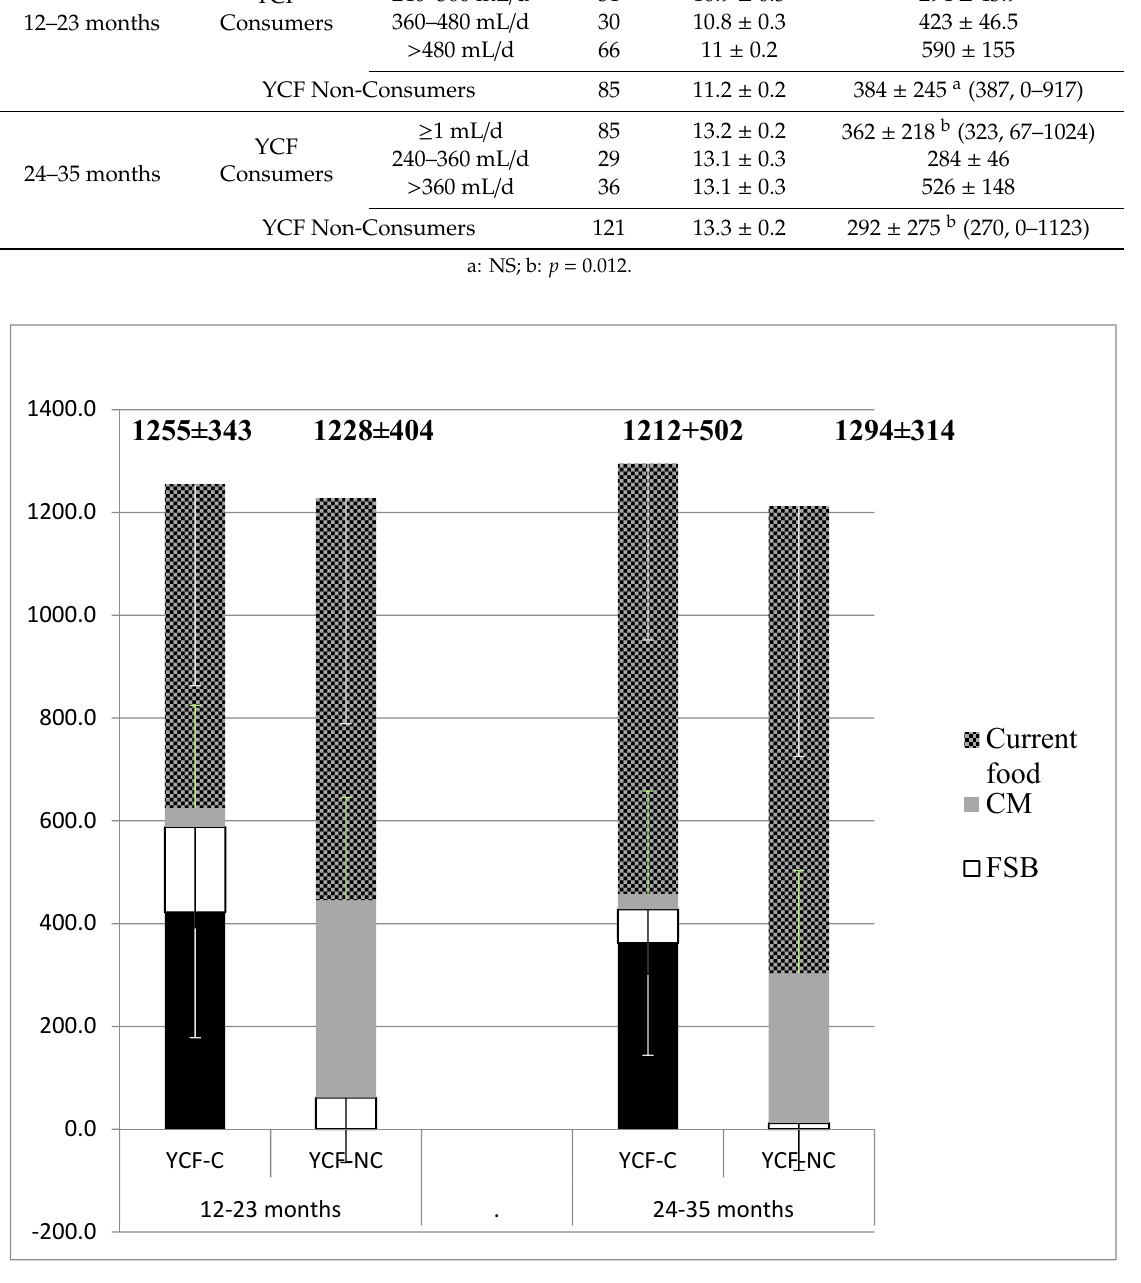
Figure 2. Mean ( ± SD) daily intake (g) of YCF, foods intended specifically for babies (FSB), CM and common foods in YCF-C ( n = 241) and YCF-NC ( n = 206) according to age